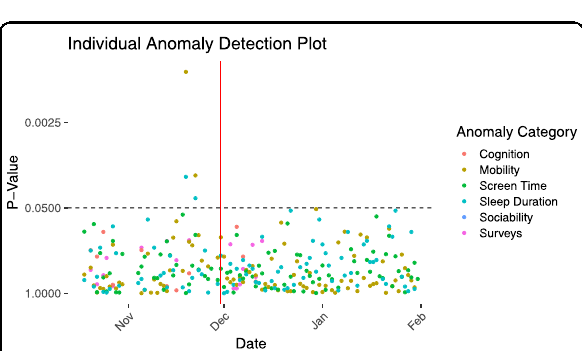
Fig. 2 Individual participant plot of single and double anomalies. The x -axis represents the date and the y -axis, plotted reverse logarithmically, represents the p-value of feature anomalies. The higher up on the y -axis, the smaller the p value, and the more signi fi cant. A horizontal dotted line is drawn at p = 0.05. Each dot represents the detection of an anomaly for a particular category on that day, with the dots above the horizontal dotted line considered signi fi cant. The red vertical line represents a relapse event (in this case, exacerbation of symptoms). Single anomalies above the signi fi cance threshold were hidden for clarity of